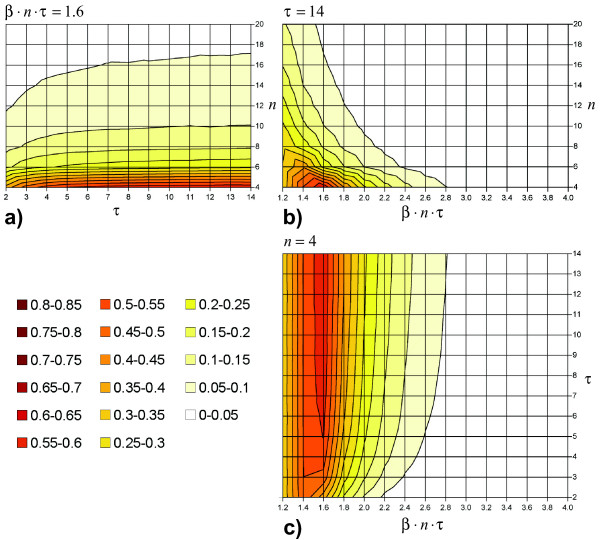
Model differences depending on τ, n and β. Subfigures a-c show the difference in the total outbreak size between a pure random mixing model and a model assuming complete repetitiveness (without clustering) relative to the population size N. Contour plots are interpolated from a grid of measurement points using Microsoft® Office Excel 2003. (a) infectious period: 2 ≤ τ ≤ 14, step width (sw): sw = 1; daily number of contacts: 4 ≤ n ≤ 20, sw = 2; per-contact transmission probability: β·n·τ = 1.6. (b) 1.2 ≤ β·n·τ ≤ 4.0, sw = .2; 4 ≤ n ≤ 20, sw = 2; τ = 14. (c) 1.2 ≤ β·n·τ ≤ 4.0, sw = .2; 2 ≤ τ ≤ 14, sw = 1; n = 4.